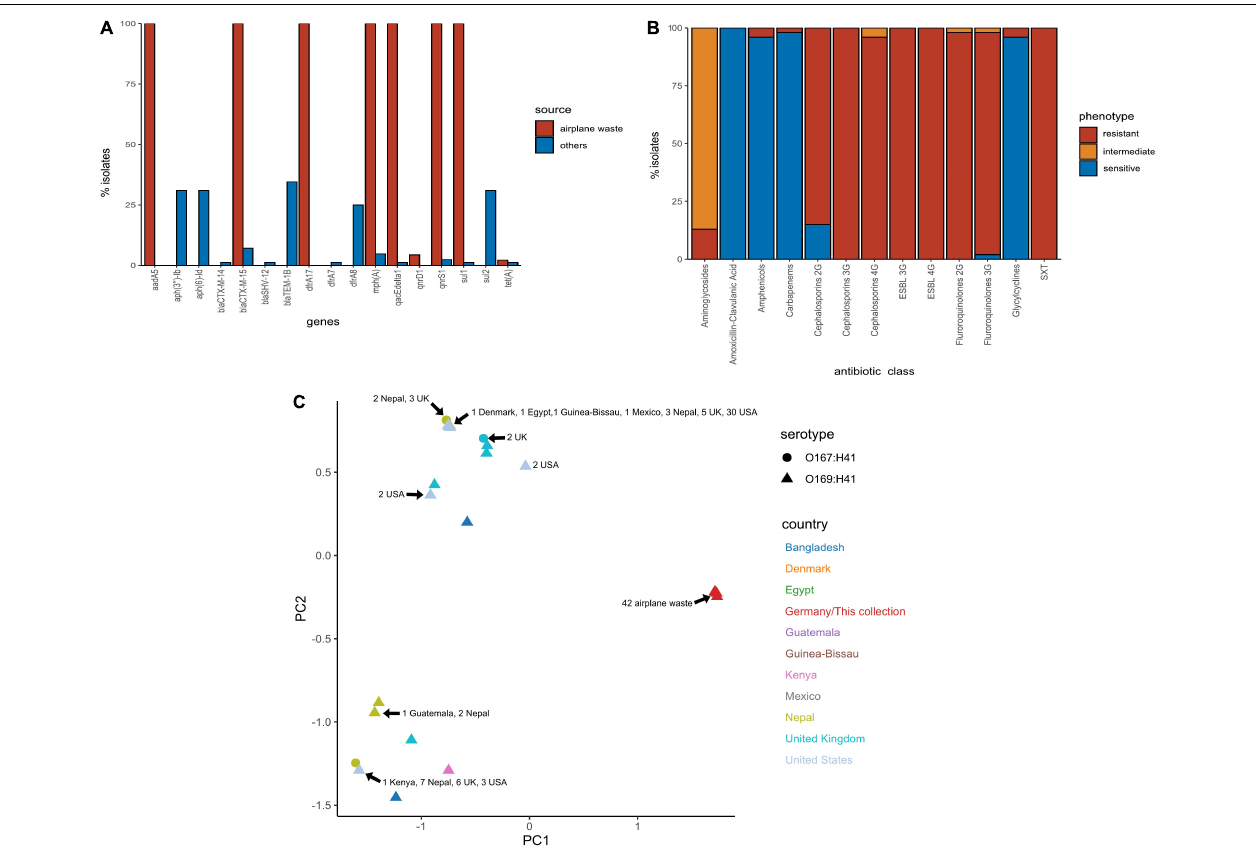
FIGURE 3 | Antimicrobial resistance (AMR) profile of E. coli ST182 strains. (A) Bar graph comparing distribution of the most common ARGs identified in both ST182 airplane waste isolates (red) and other ST182 strains (blue). (B) Phenotypic AMR profile of ST182 airplane waste isolates. Red = resistant isolates (%), orange = intermediate (%), blue = sensitive (%). (C) MDS analysis of ARGs detected in ST182 isolates. Where identical profiles cause shapes to overlap arrows have been added detailing the country of isolation for each clustered